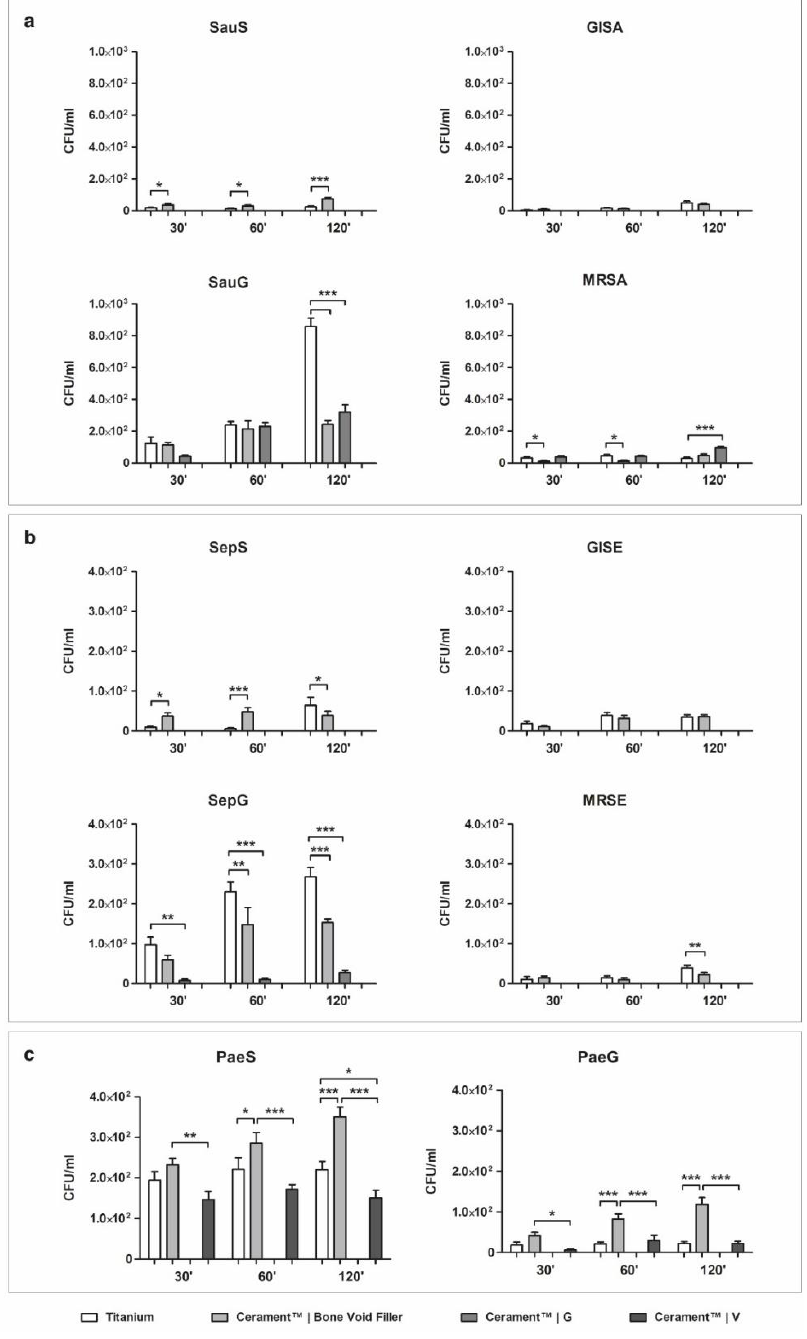
Figure 1. Bacterial adhesion on material surface as determined by plating and colony counting. ( a ) Staphylococcus aureus , ( b ) Staphylococcus epidermidis and ( c ) Pseudomonas aeruginosa adhesion on sandblasted titanium (ST), ceramic bone void filler (CBVF), ceramic filler containing gentamicin (CG) and ceramic filler containing vancomycin (CV) after 30, 60 and 120 min of incubation. Statistical significance: p < 0.05 (*), p < 0.01 (**) and p < 0.001 (***).